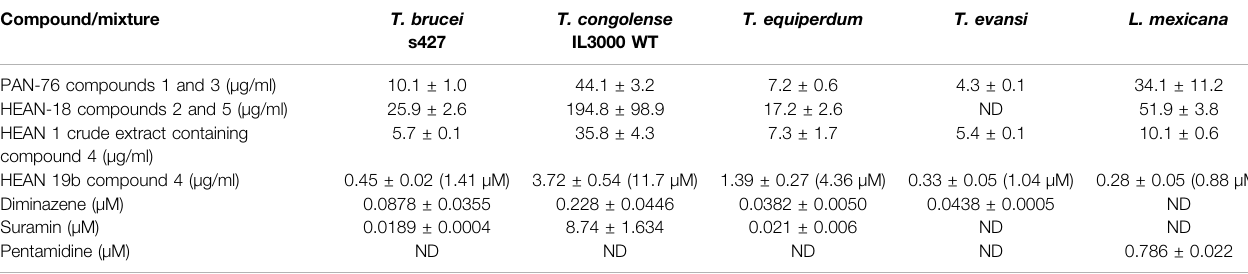
TABLE 2 | EC 50 of two mixtures and compound 4 against Trypanosoma and Leishmania species ( n (cid:2) 3). Compound/mixture